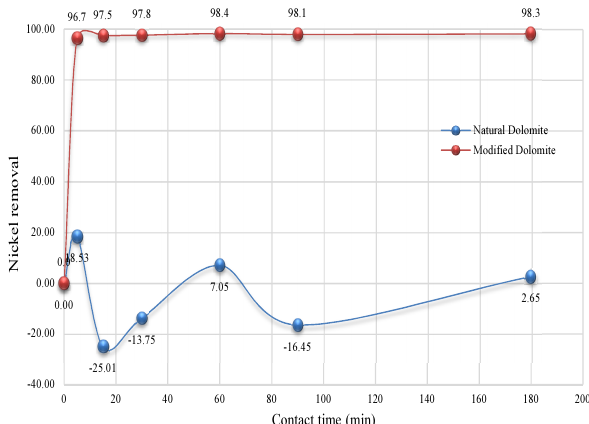
Fig. 4. Comparison of removal efficiency (%) of nickel from solution (5 mg/l) by natural dolomite and modified dolomite (1 g) within specified contact